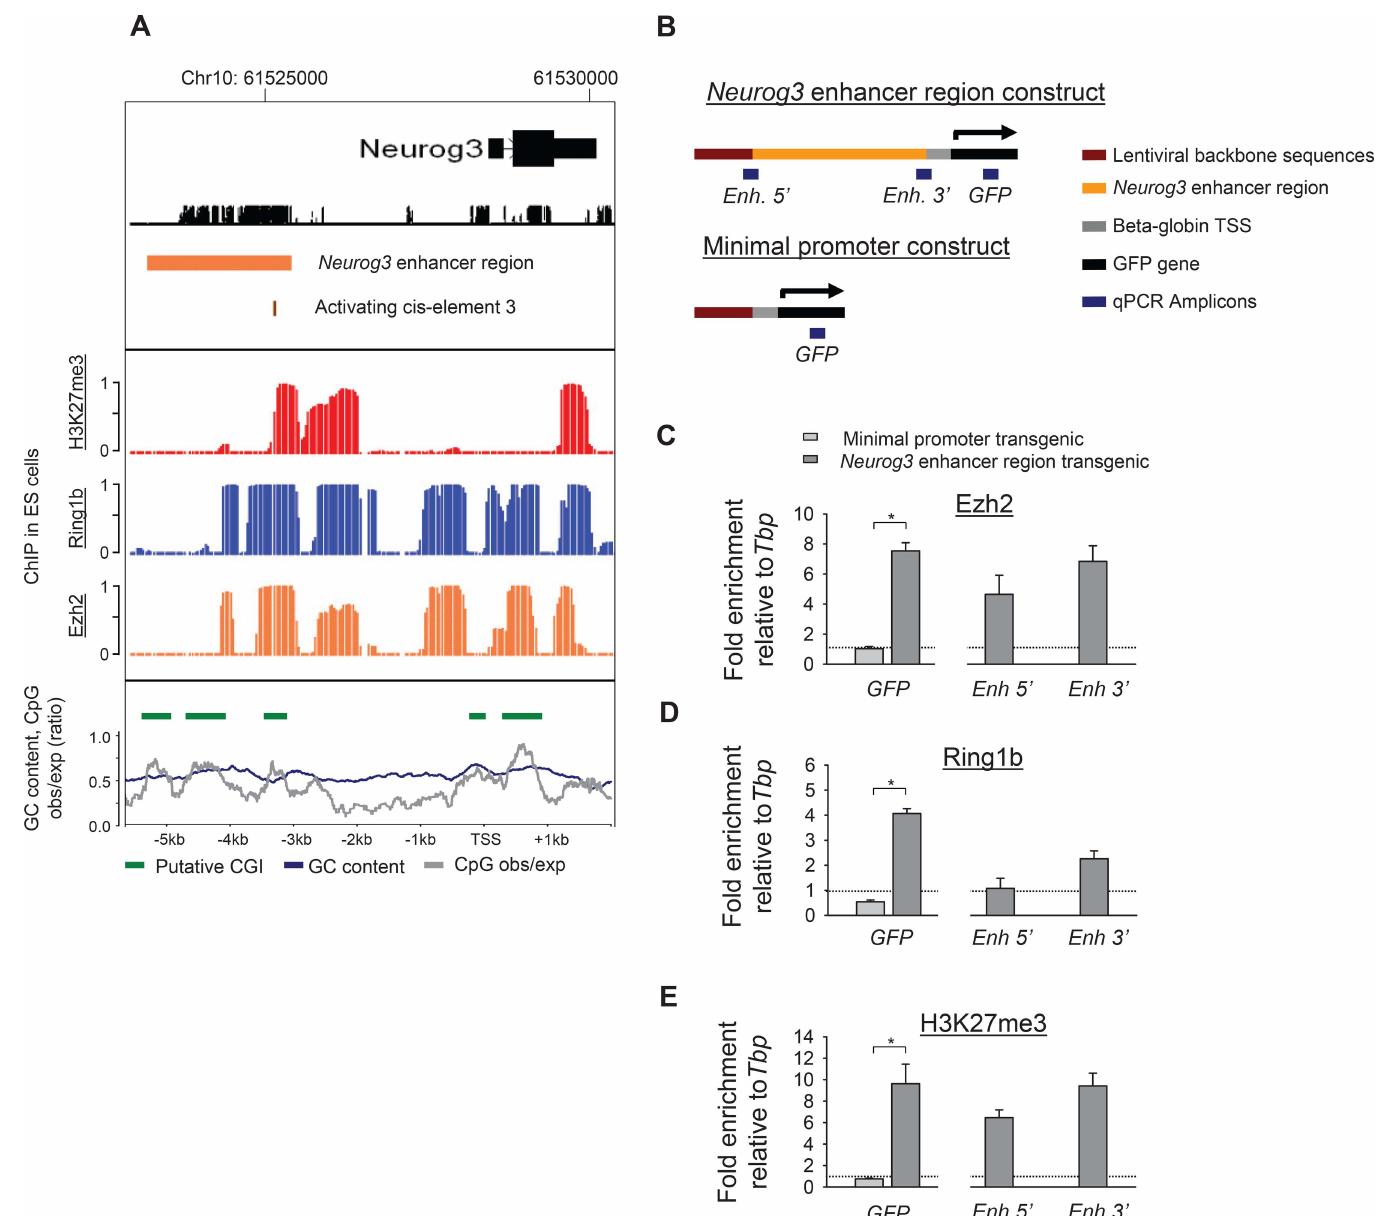
Fig 5. The minimal Neurog3 enhancer functions as a PRE in vivo . A. ChIP-oligonucleotide array analysisof the endogenous mouse Neurog3 locus in ES cells. The graph shows significance of enrichments for H3K27me3(red), Ring1b(blue), and Ezh2 (orange) in posterior probabilityrangingfrom 0 to 1. The bottom panel shows a CpG content analysisfor the same genomiccoordinates. The averageGC content in 400 bp slidingwindowsis shown in blue and the CpG fold over expectedis shown in grey. Green bars depict putative CpG islands. B. Schematic representation of ampliconsused in ChIP-qPCR to selectivelystudy the integratedexogenous Neurog3 enhancerregionor the control minimalpromoter (note that only GFP can be used on both). C-E. ChIP- qPCR analysisfor Ezh2, Ring1b and H3K27me3 on the exogenous Neurog3 enhancer regionin transgenicE13.5 liver (n = 2) ([ * ] P < 0.01, Student’s